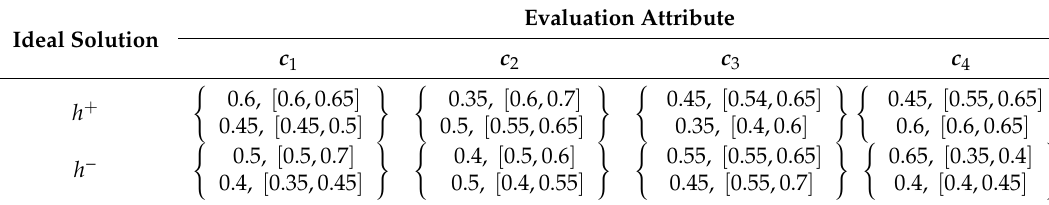
Table 5. PIS & NIS for each attribute.